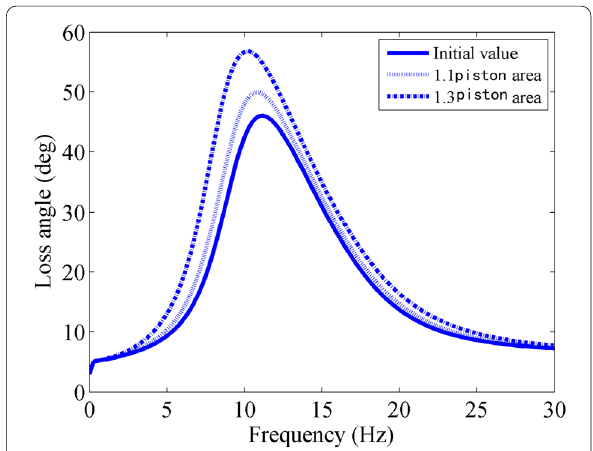
Figure 13 Loss angle vs. frequency curves in different inertial channel areas